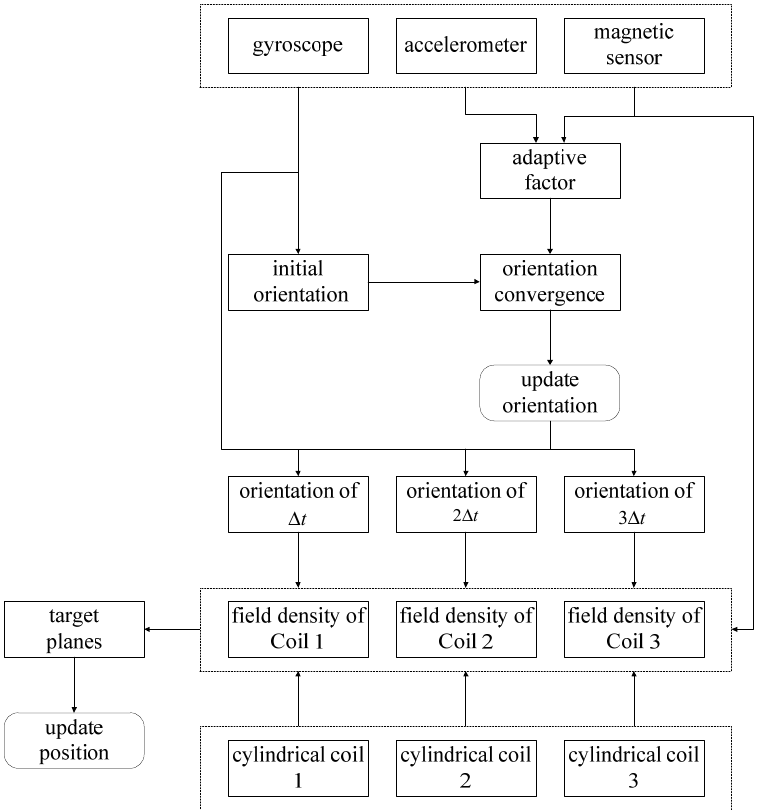
Figure 7. Tracking solution for ultrasonic